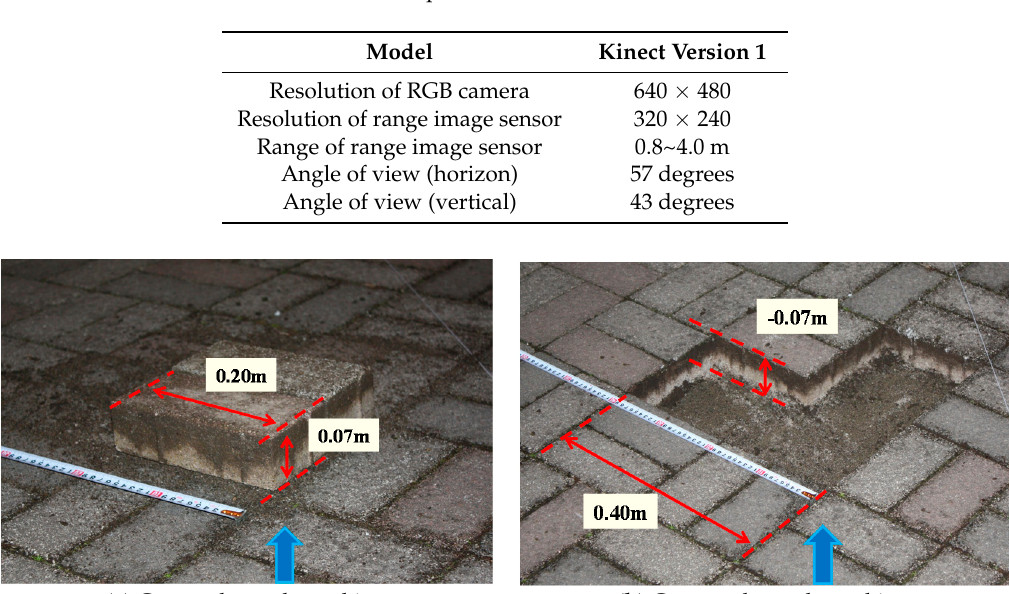
Table 1. Specifications of Kinect v1.